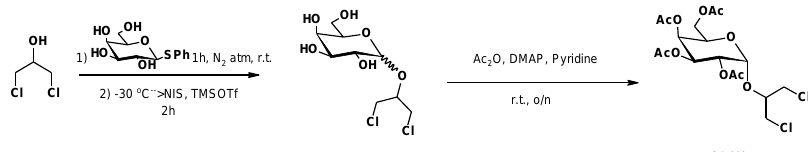
Figure 12. Synthesis of the copper complexes CuL1.